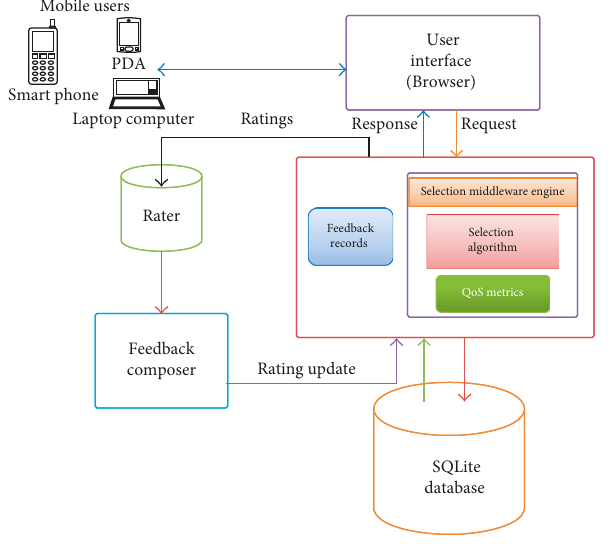
Figure 3: Rating mechanism in AMC service